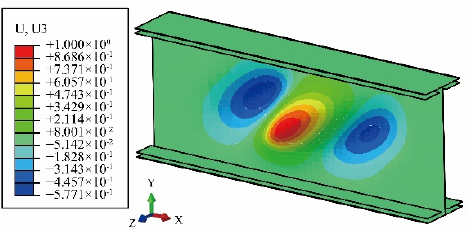
Figure 25. The numerical result of the first buckling mode from the linear buckling analysis on the BW-I composite beams under shear load.